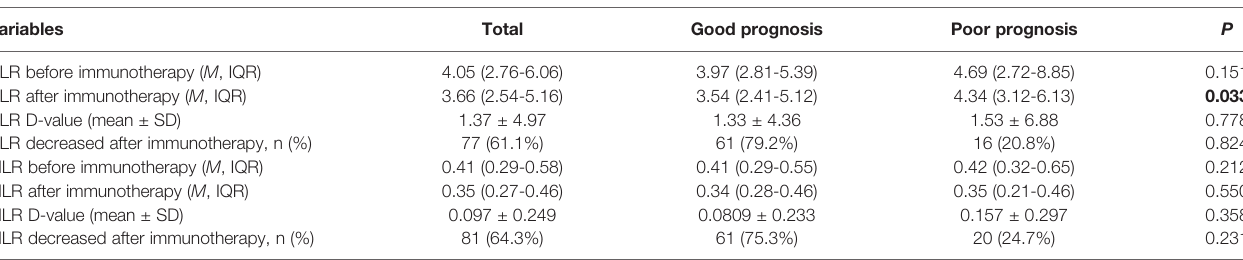
TABLE 7 | NLR and MLR (before and after